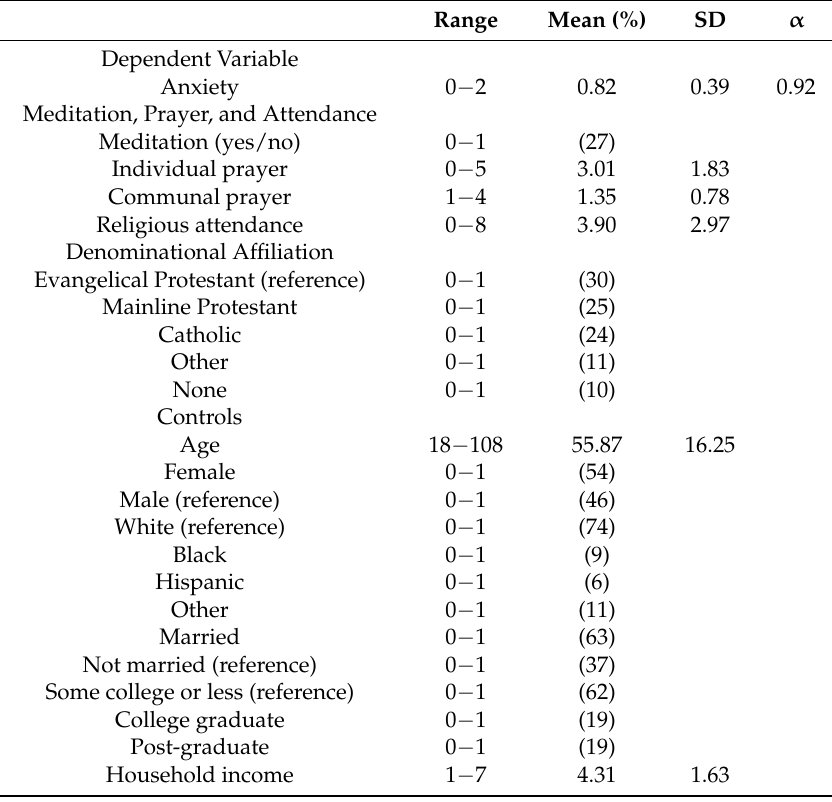
Table 1. Descriptive Statistics ( n =